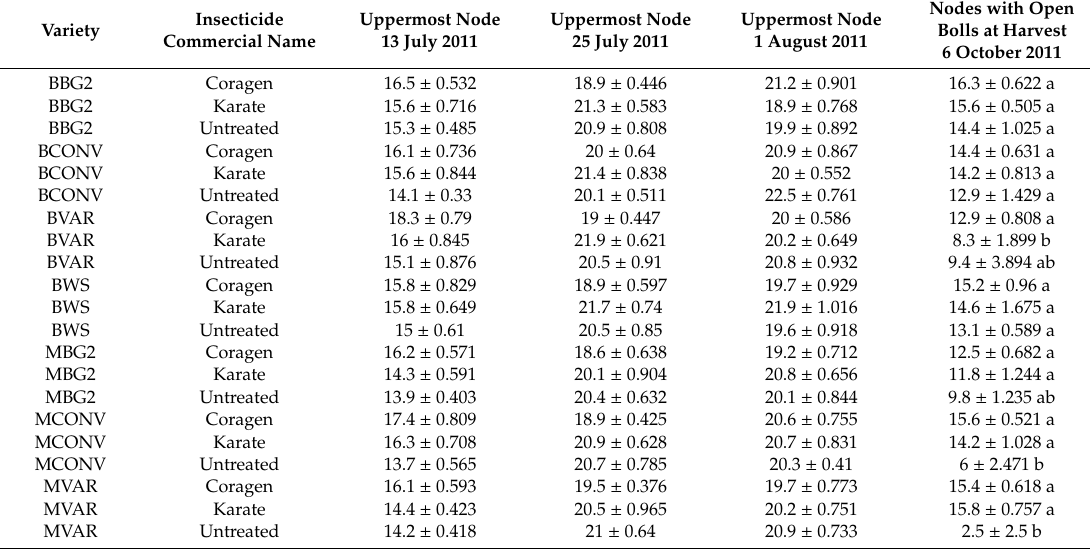
Table 5. Mean ± SEM uppermost node bearing fruit per plant on three within-season sample dates and at total nodes with open bolls at harvest in 2011. Means not followed by a common letter indicate significant di ff erences between treatments based on LSD at p <